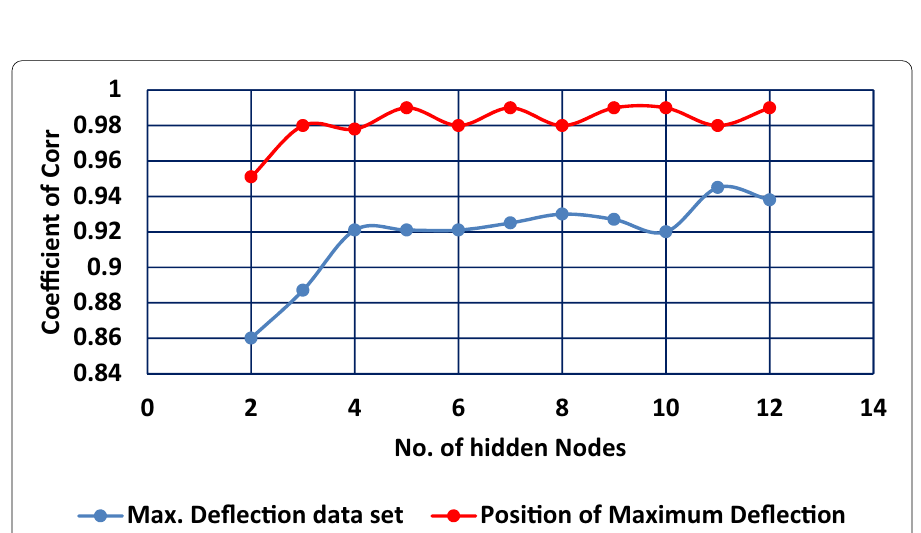
Fig. 5 Variation of Coefficient of correlation with different hidden